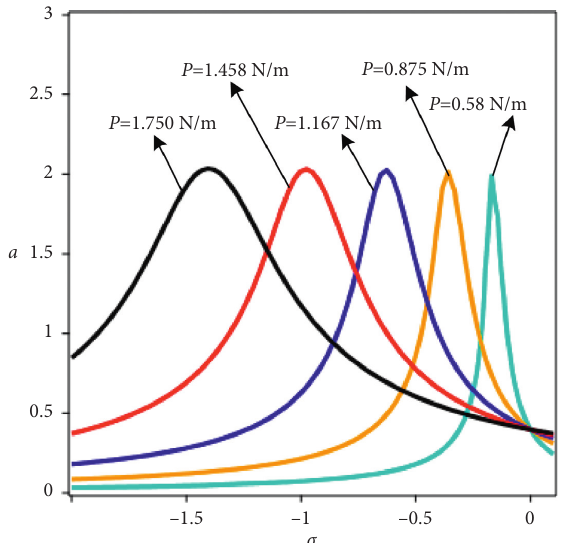
Figure 18: The 2-order super-harmonic amplitude-frequency re- sponse curve (varied P ).